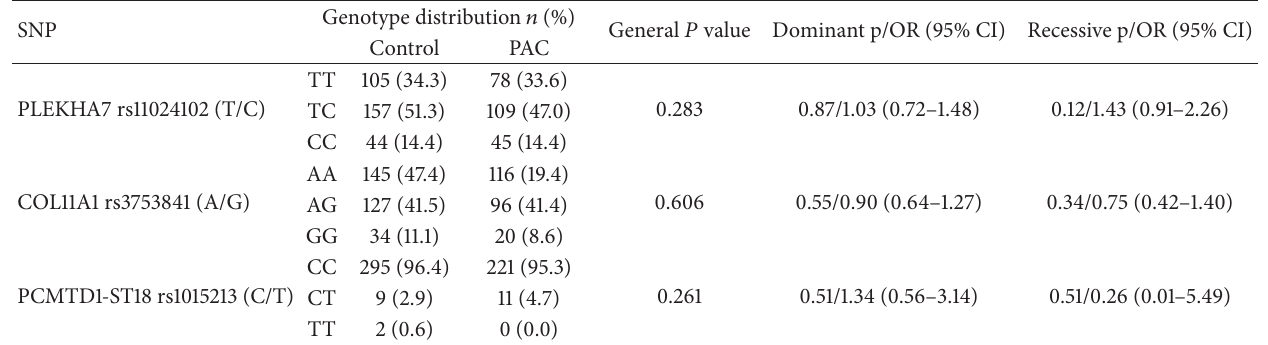
Table 4: Genotype frequency of SNPs in control and PAC subjects.